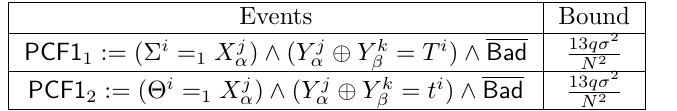
Table 5: Bound for the joint event (i) PCF1 1 ∧ Bad and (ii) PCF1 2 ∧ Bad . Events